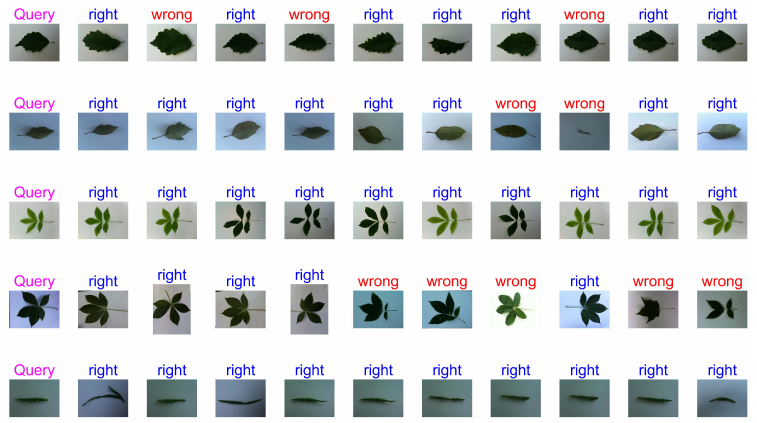
Figure 16. Top 10 retrieval images for five leaf images from Leafsnap